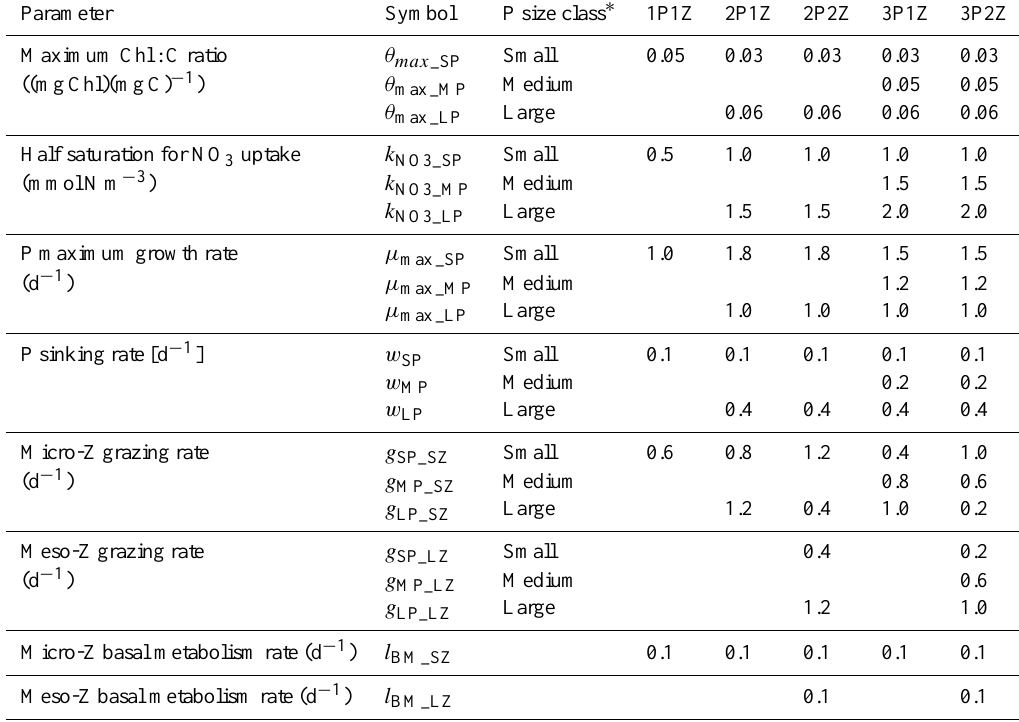
Table 1. Key parameters that differentiate the phytoplankton (P) and zooplankton (Z) size classes.